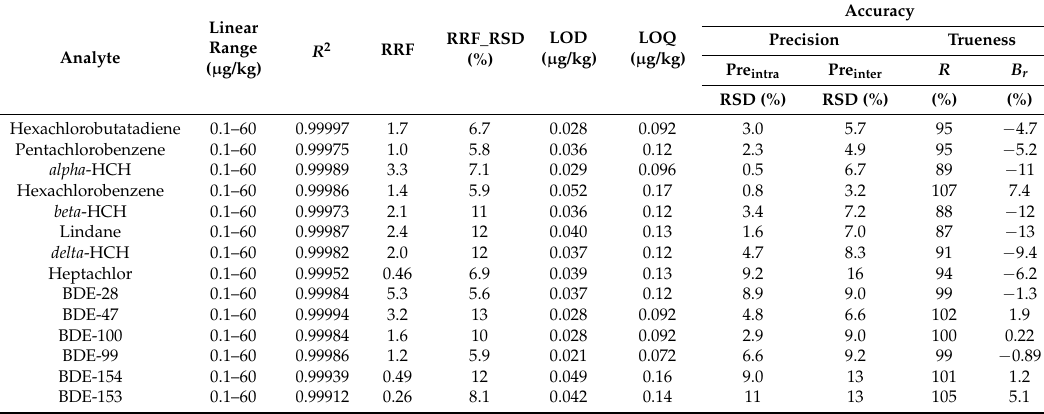
Table 3. Linearity, limits and accuracy of the proposed method for determination of test analytes in spiked fish